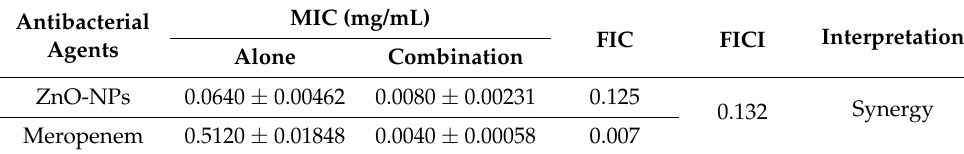
FIC FICI Interpretation